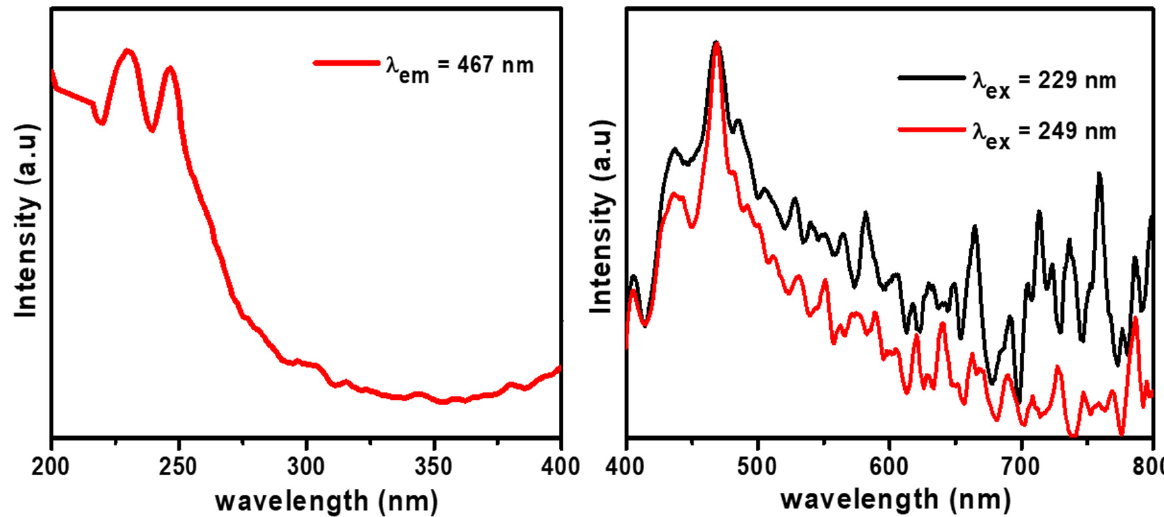
Figure 7. Photoluminescence analysis results of the GL–CMC–ZnO NCs.